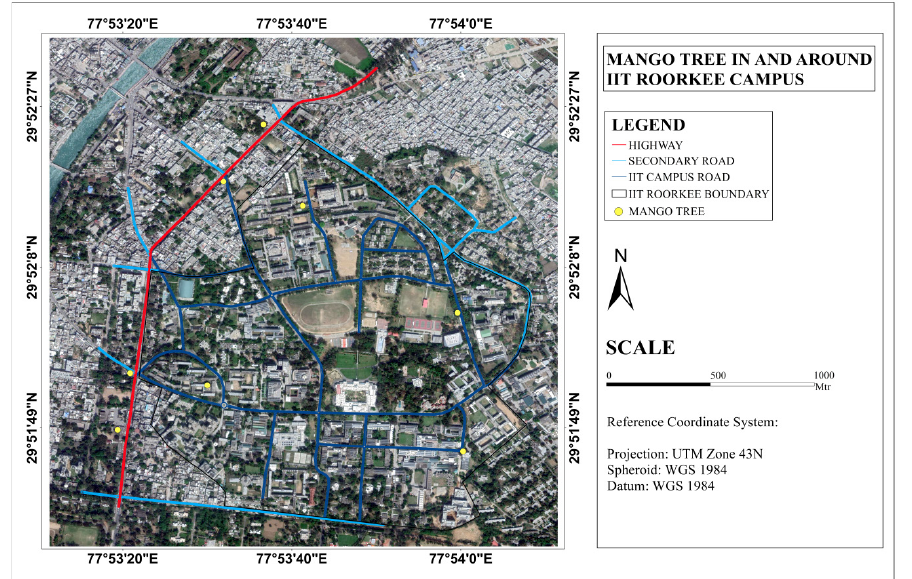
Figure 1.Location map of the study are and position of mango tree